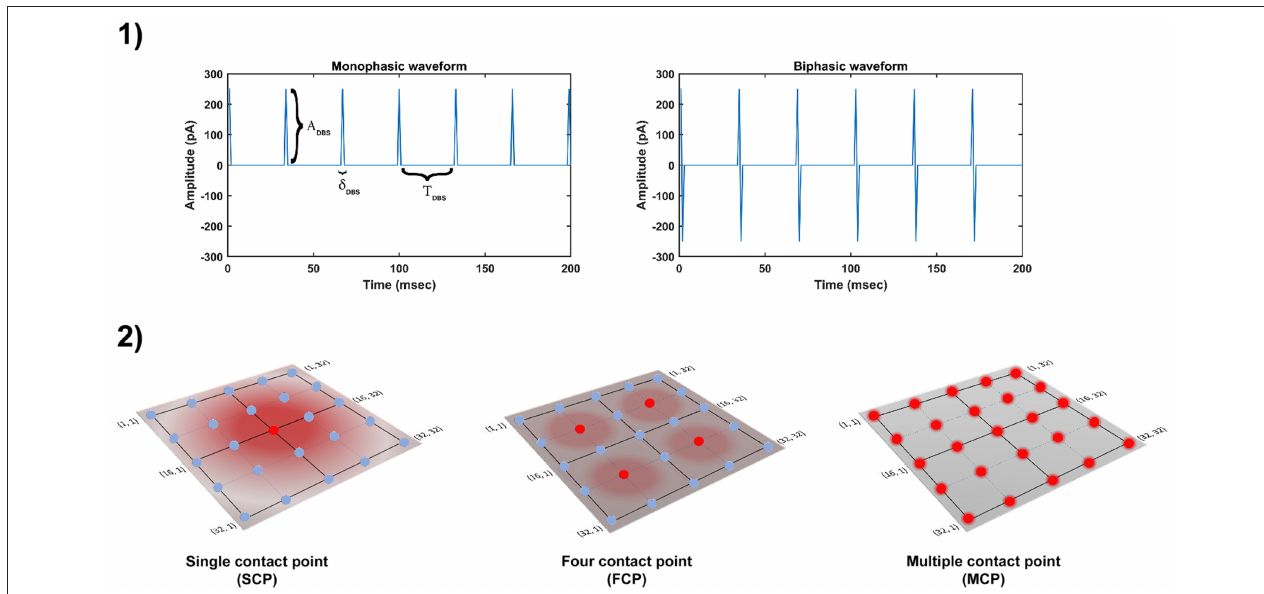
FIGURE 2 | Different DBS protocol used in the study. (1) DBS stimulation waveforms. (2) DBS stimulation configurations. DBS, Deep Brain Stimulation; A DBS , Amplitude of DBS current pulse; δ DBS , Pulse width of DBS current pulse; T DBS (1 / f DBS ), frequency of DBS current pulse; SCP, Single Contact Point; FCP, Four Contact Point; MCP, Multiple Contact